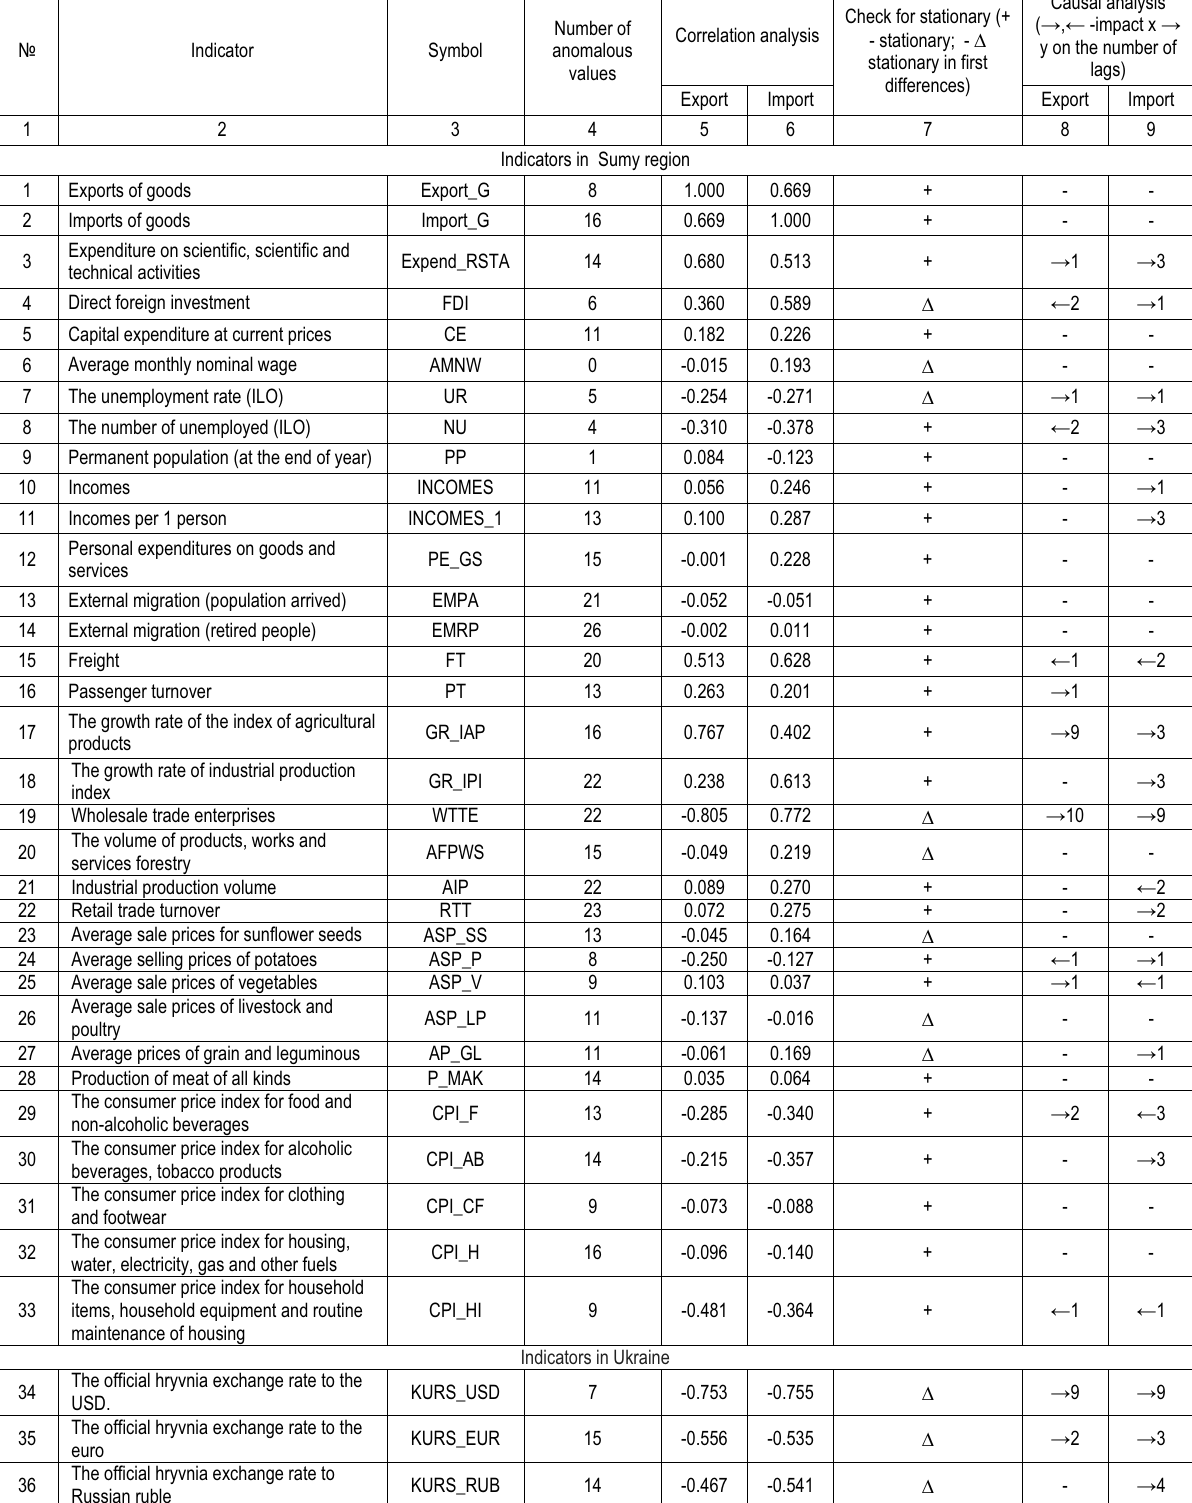
Table 1. Conditional results of 2, 3 and 4 stages of VAR model